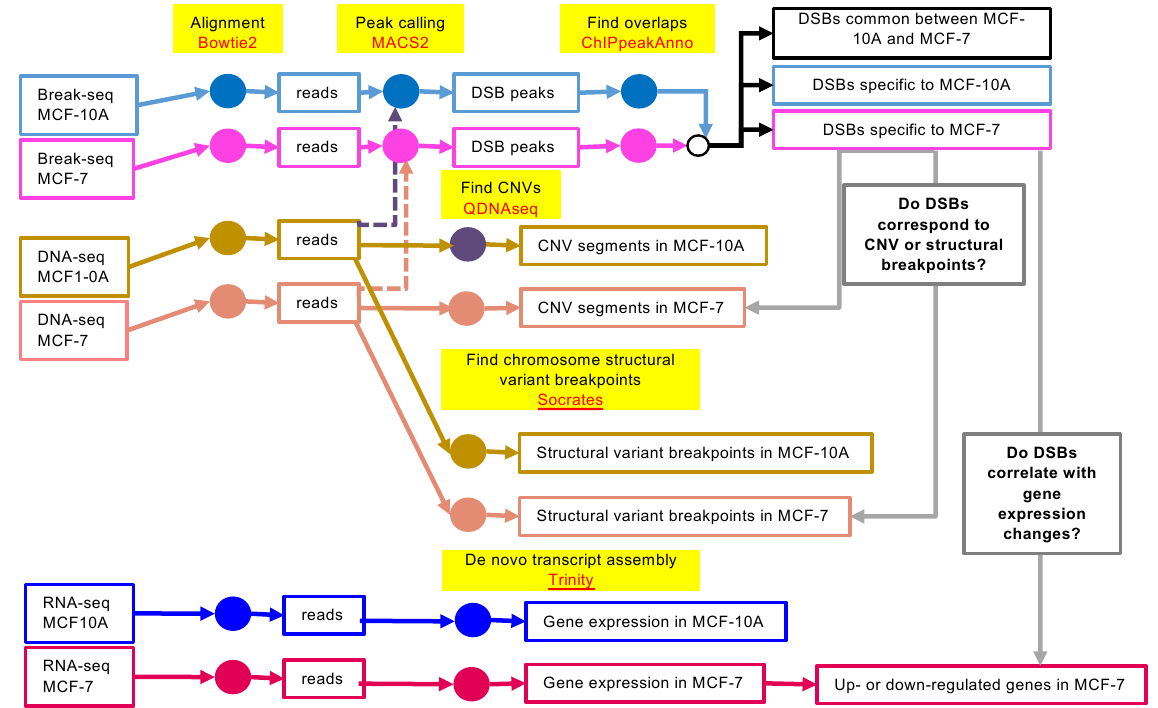
Figure 1. Experimental design. Work flow for multi-dimensional genomic queries of the MCF-7 and MCF-10A cell lines for the identification of cancer-specific chromosome breakage sites and poten- tially impacted genes. The color-coded nodes denote the analytical steps utilizing the highlighted computational